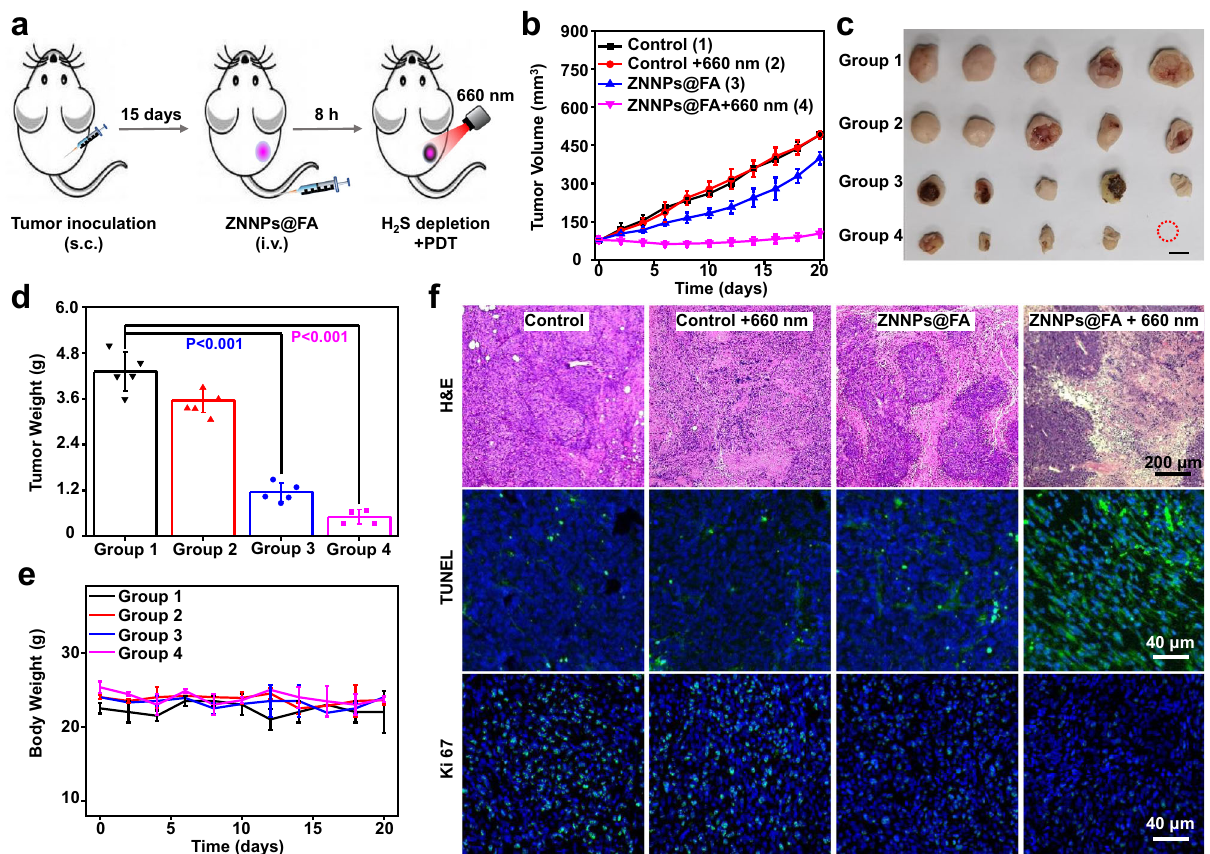
Fig. 8 In vivo PDT of HCT116 subcutaneous tumors with ZNNPs@FA. a Schematic for tumor construction and PDT treatment. b Tumor growth pro fi les of the mice treated by PBS buffer (200 μ L) or ZNNPs@FA (10 mg/kg), and mice in the second and fourth groups were treated with 660 nm laser irradiation (50 mW/cm 2 , 3 min) at 16 h. c Tumor images and d tumor weight of each group at the end of treatment. e Body weight following above treatments. f H&E, Tunnel, and ki67 staining images of tumor slices 2 days after indicated treatments. Data are presented as mean ± s.d. ( n = 5). Statistical differences were analyzed by Student ’ s two-sided t-test. Source data are provided as a Source Data fi